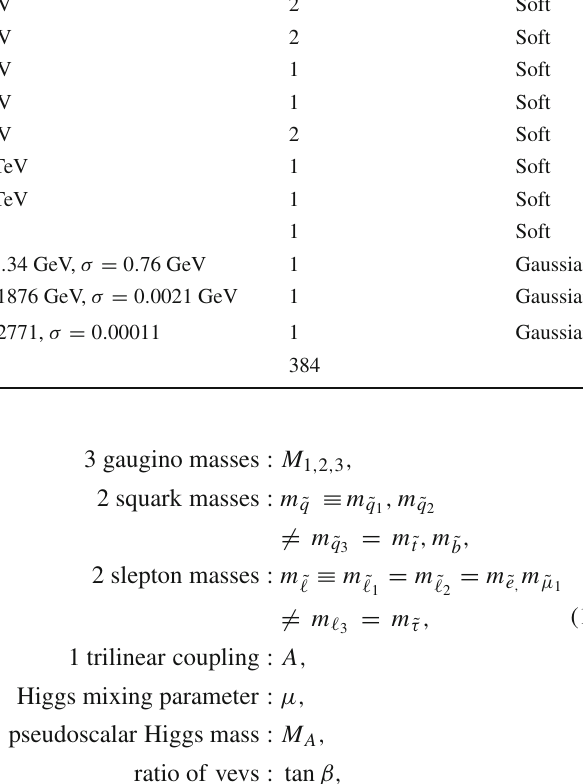
Table 1 The ranges of the Parameter Range Number of segments Prior type pMSSM11 parameters sampled, which are divided into the M 1 ( − 4, 4)TeV 6 Soft indicated numbers of segments, M 2 (0, 4)TeV yielding the total number of sample boxes shown in the last row. In the last column, we indicate the kind of prior used, where “soft” means a flat prior with Gaussian tails